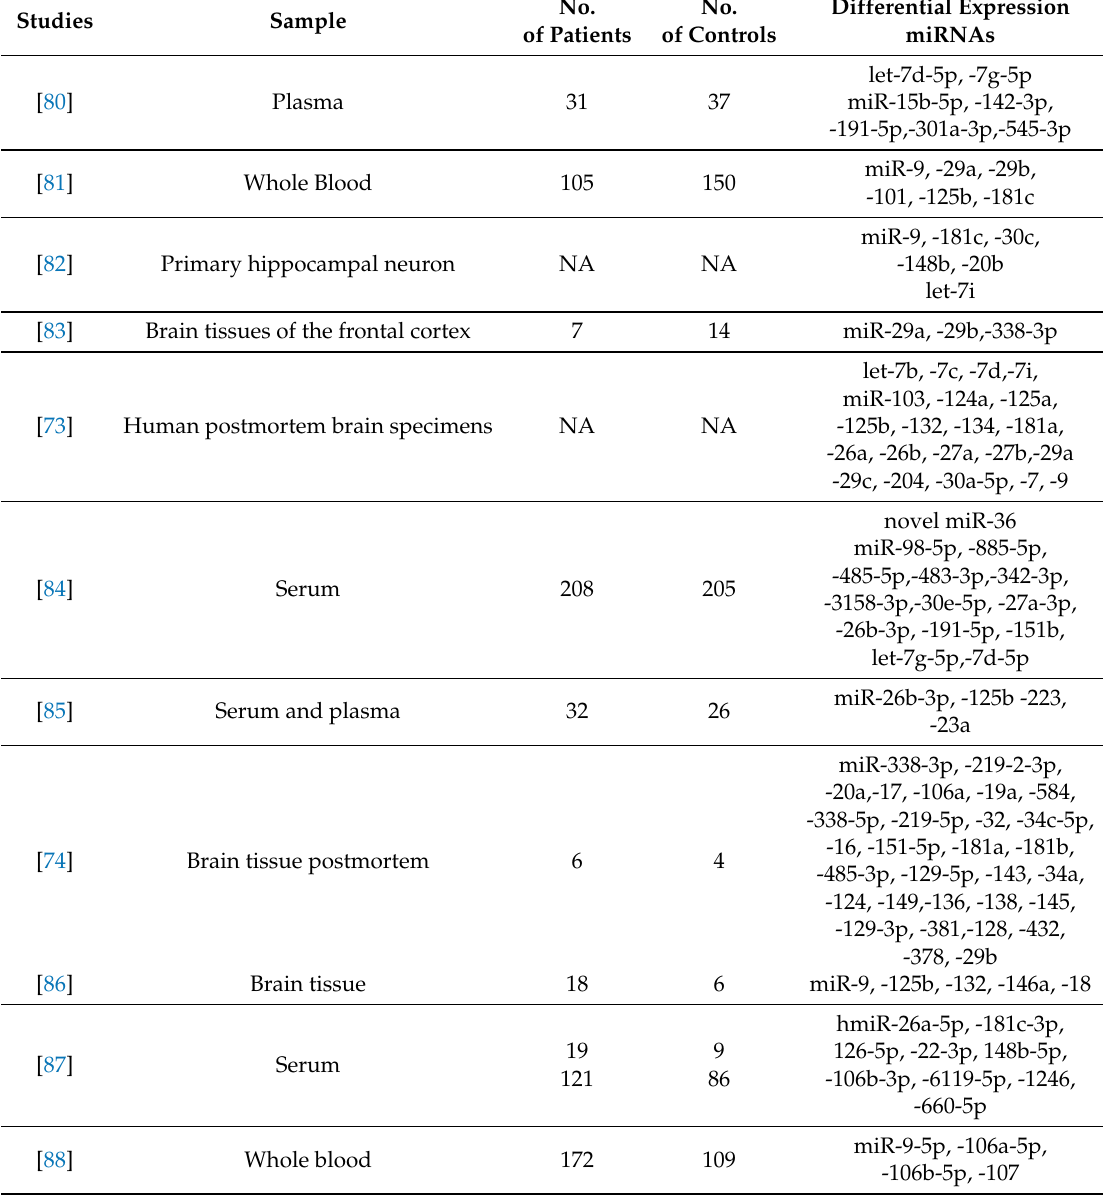
Table 5. Micro-RNA studies in